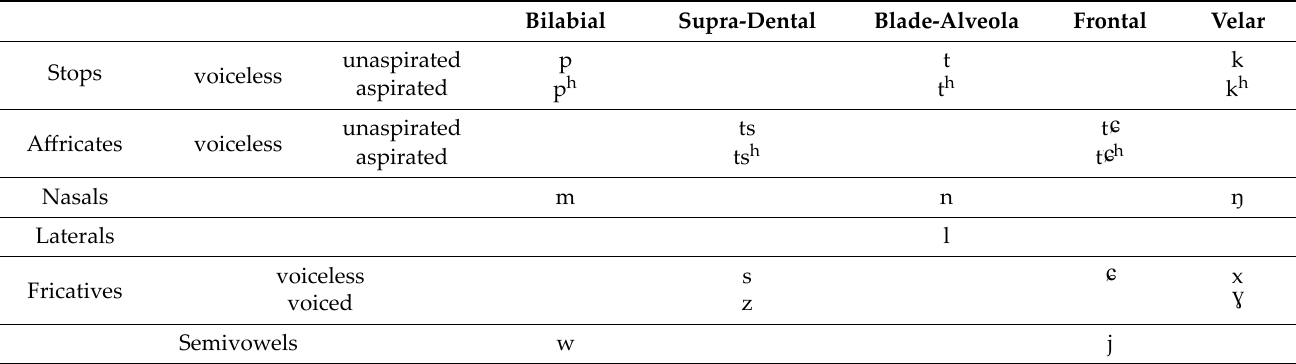
Table 2. Initials of Tujia language.